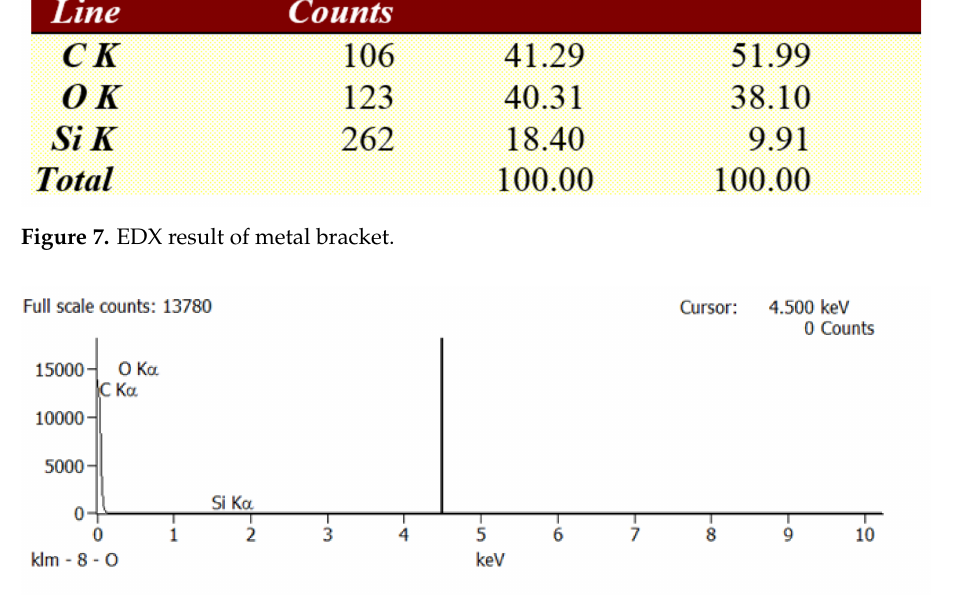
Figure 8. Graphical representation of the EDX analysis presented above.